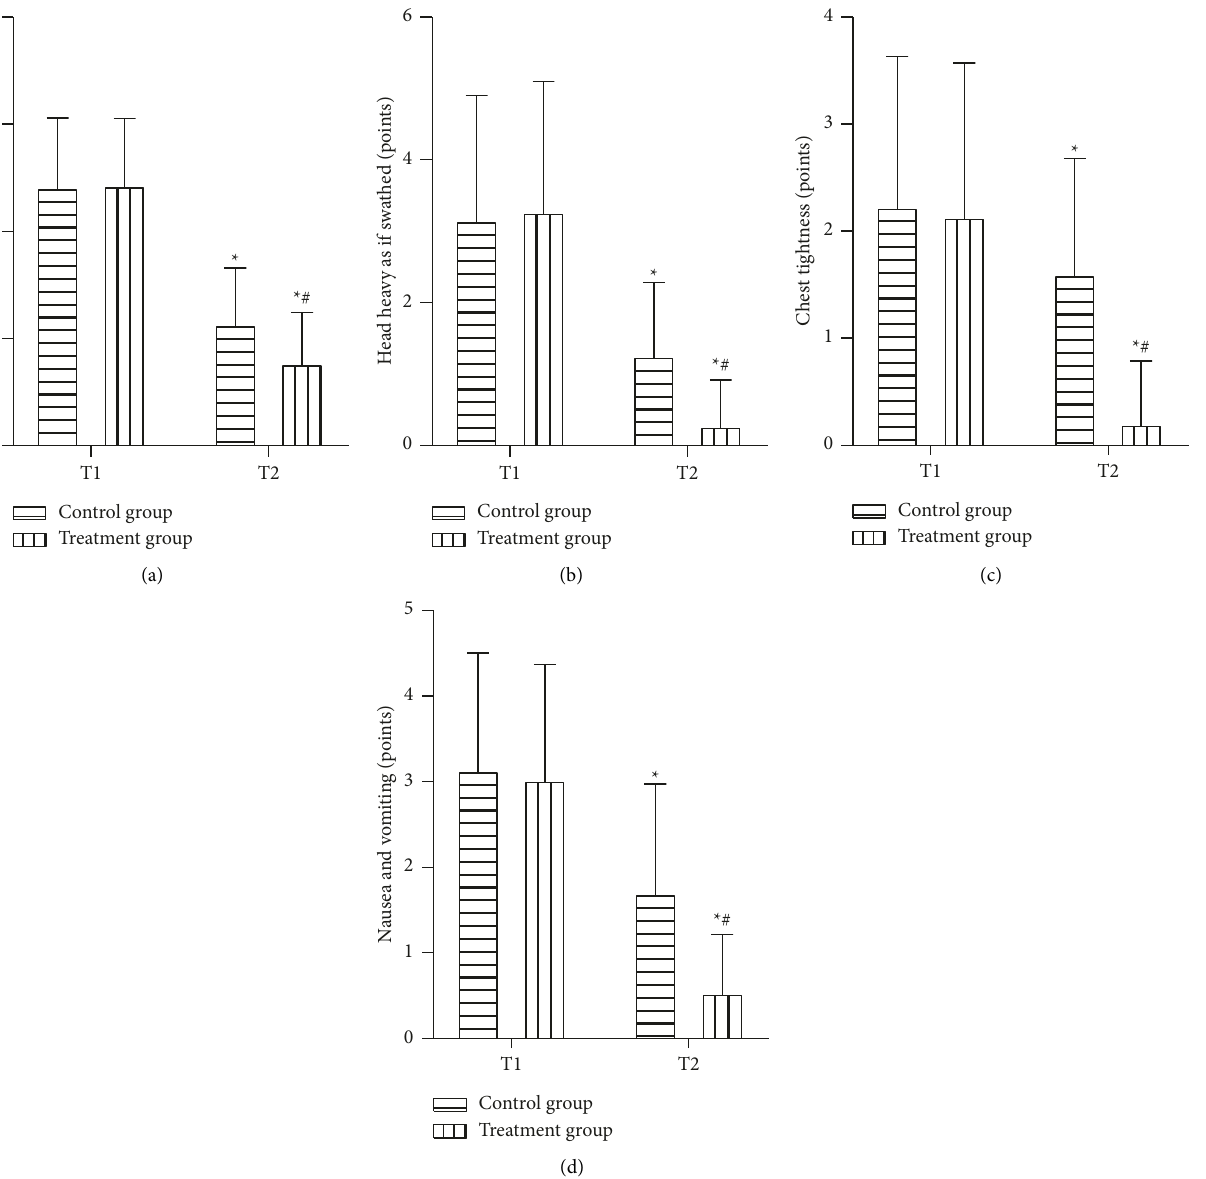
Figure 4: (a) vertigo score, (b) head heavy as if swathed score, (c) chest tightness score, and (d) nausea and vomiting score. ∗ indicates a significant difference between each group compared with the same group at T1 ( P < 0 . 05). # indicates significant difference ( P < 0 . 05) between the 2 groups at